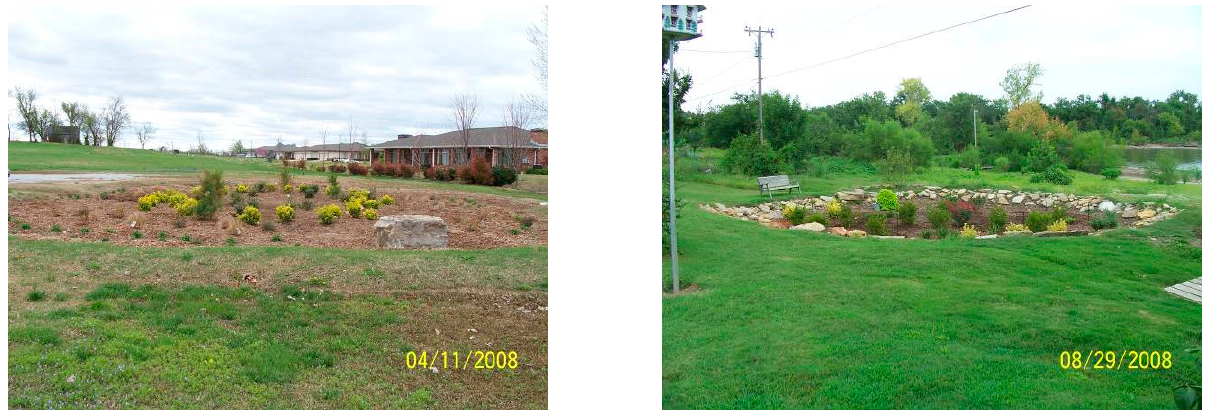
Figure 5. Completed BRC; ( left ) GLA, ( right ) SR.